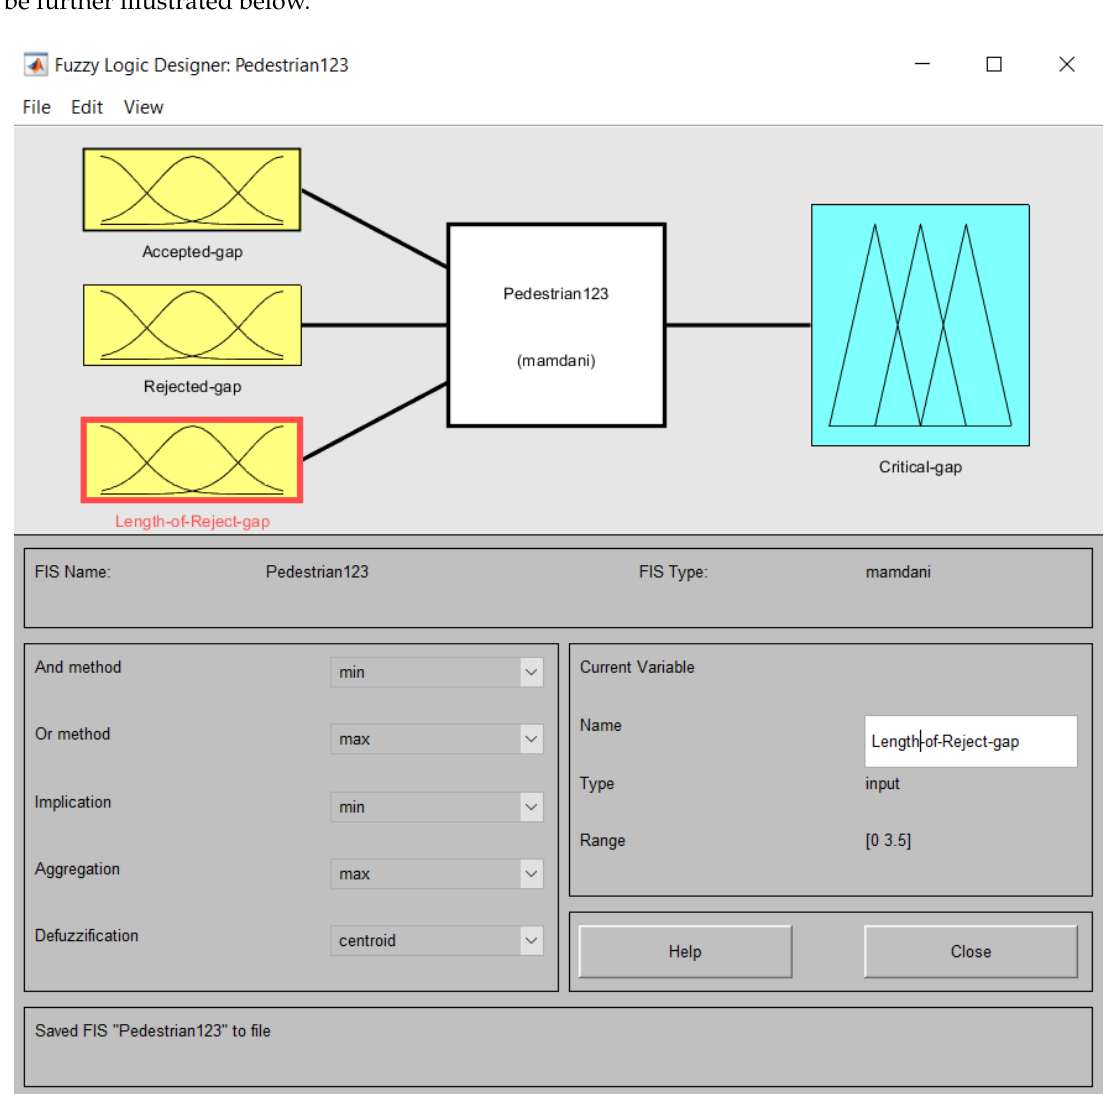
Figure 3. Fuzzy logic system for pedestrians’ gap acceptance.